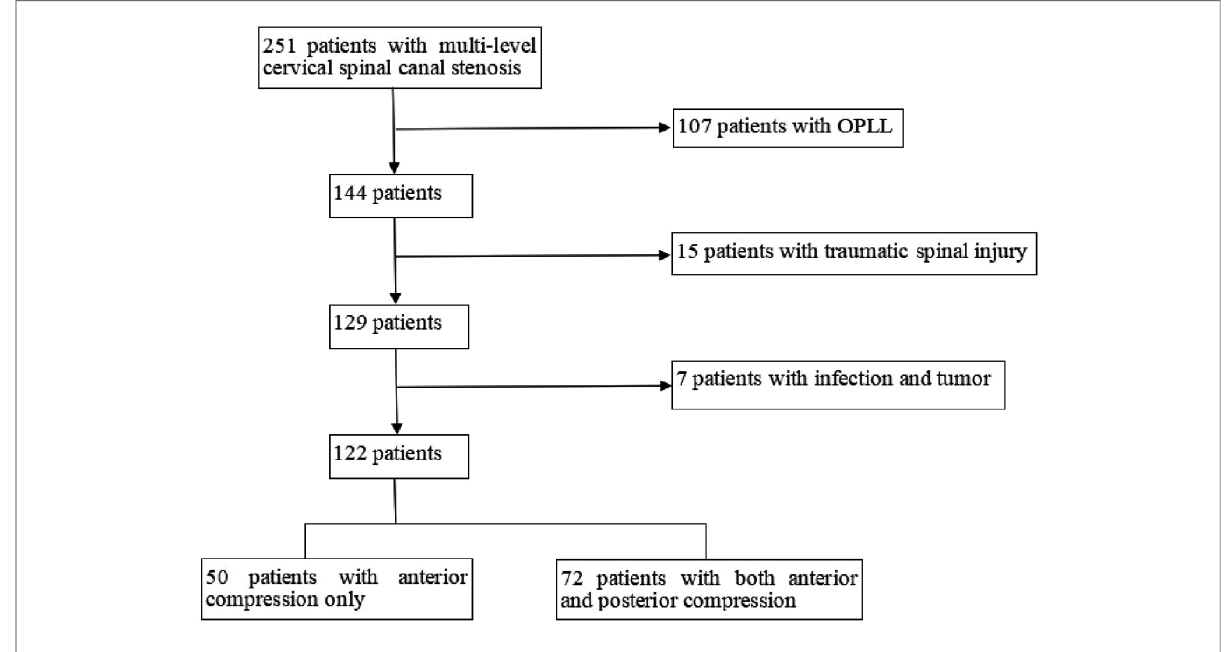
FIGURE 1 Flowchart of the collection of the study